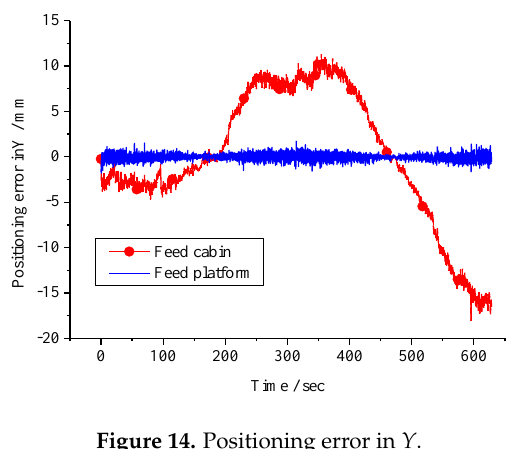
Figure 14. Positioning error in Y .